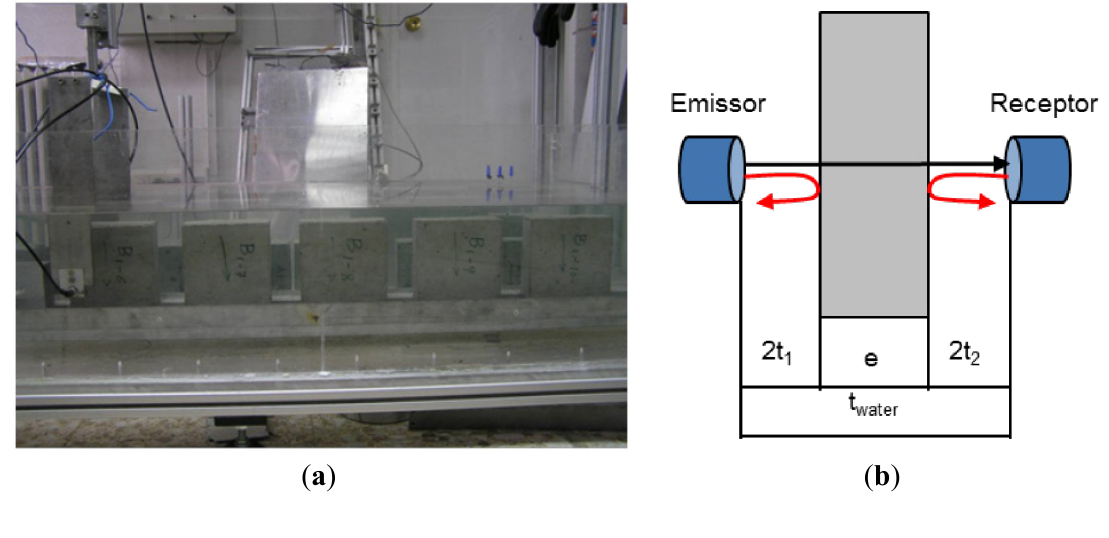
Figure 7. ( a ) Automated inspections of concrete specimens; ( b ) Schematic representation of ultrasonic inspections, transmission (black) and pulse-echo